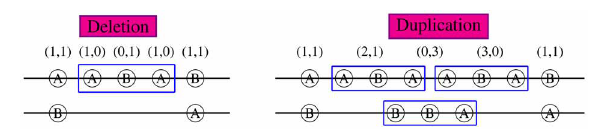
FIGURE 1 | CNP and haplotype configurations within a 5-locus block. 2-digit CNP at each locus was shown on top. Specific alleles A or B are shown in each circle at the corresponding loci aligned on a pair of chromosomes. The long lines between two loci denote deletion regions (no corresponding alleles). Both deletion (left) and duplication (right) occur from loci 2 to